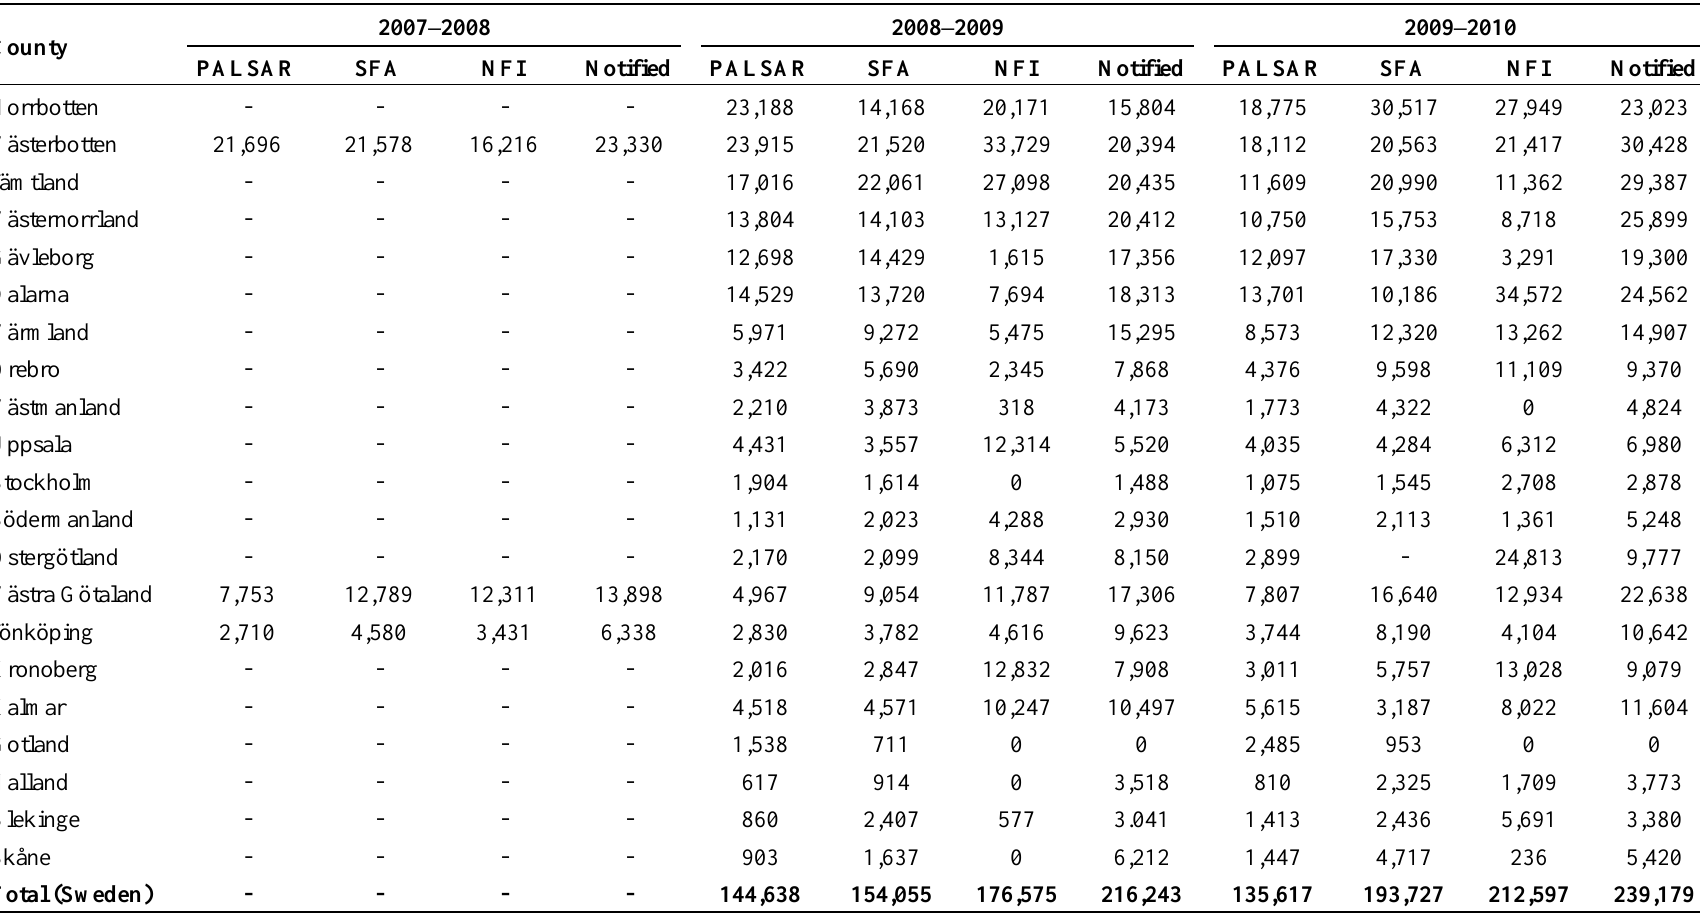
Table 4. County and national level statistics of clear-felled areas in hectare for three consecutive years from ALOS PALSAR K&C strip data (PALSAR), the Swedish Forest Agency (SFA), the National Forest Inventory (NFI), and notified areas of final fellings recorded by the SFA (Notified)